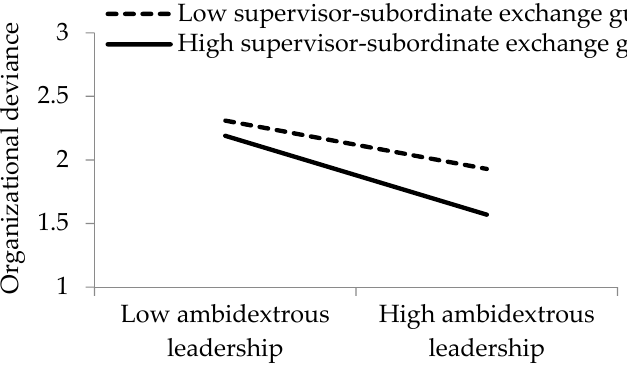
Figure 2. Influence of ambidextrous leadership on organizational deviance under different supervisor–subordinate exchange guanxi scenarios.